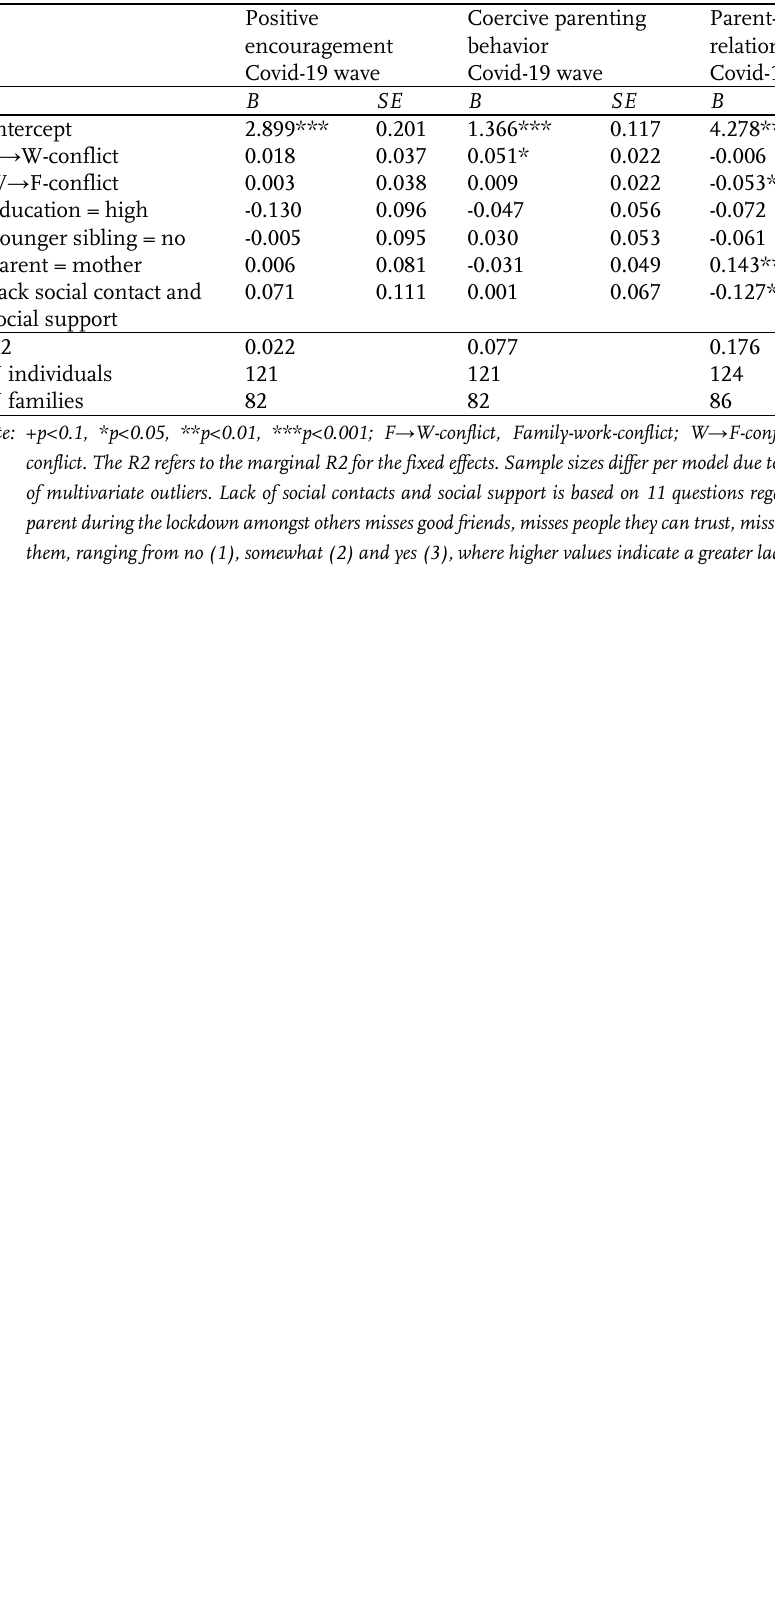
Table A.3d: Multilevel regression models on perceived parenting among mothers and fathers during the Covid-19 wave, while controlling for lack of social contact and social